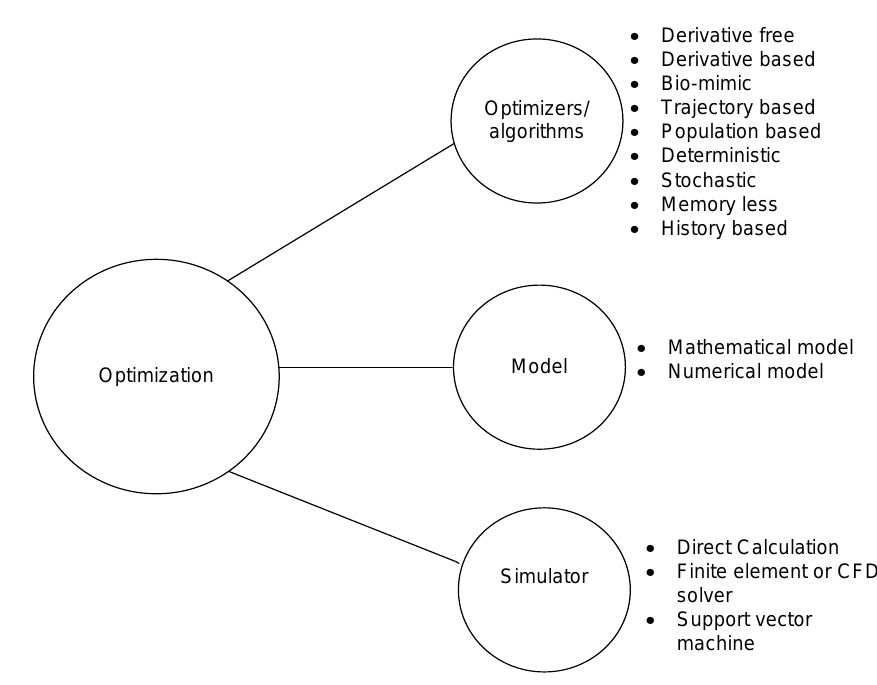
Figure 1. A simple optimization